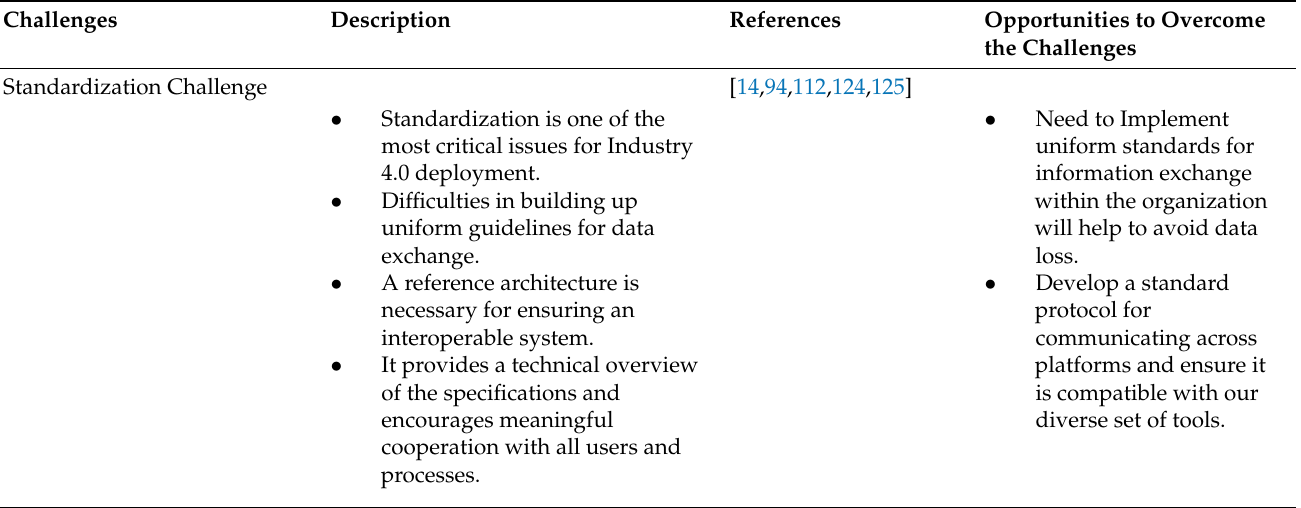
Table 5. Challenges and opportunities to over the